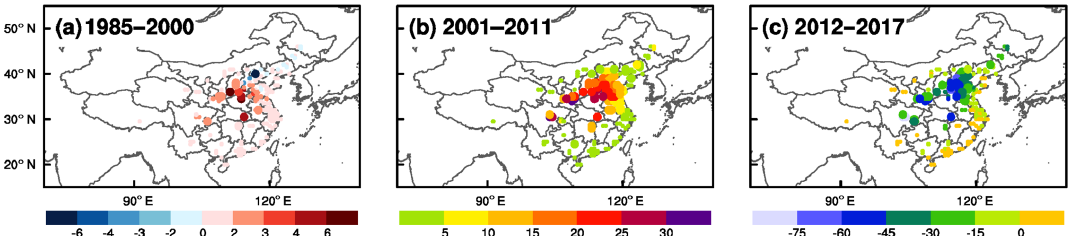
Figure 7. Linear trends of simulated frequencies (d per decade) of SWHDs at 161 model grids over the three periods of (a) 1985–2000, (b) 2001–2011, and (c) 2012–2017. Large dots indicate statistical significance above the 95% confidence level, while smaller ones are not statistically significant.